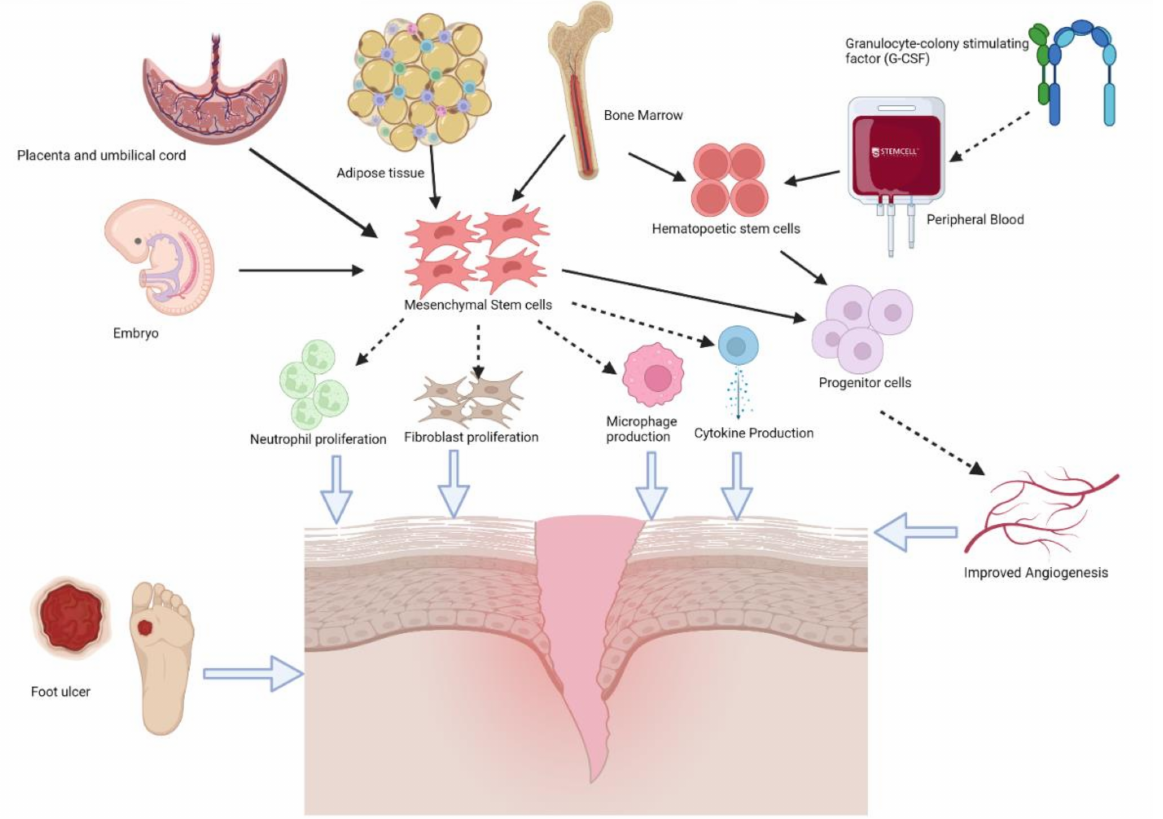
Figure 2. Differentiation of stem cells and their therapeutic potential in DFU healing (created with BioRender). Stem cells differentiate from different sources (e.g., embryo, placenta and umbilical cord, adipose tissue, bone marrow, peripheral blood). Therapeutic mechanism of stem cells in DFU healing includes neutrophil proliferation, fibroblast proliferation, microphage production, cytokine production, and improved